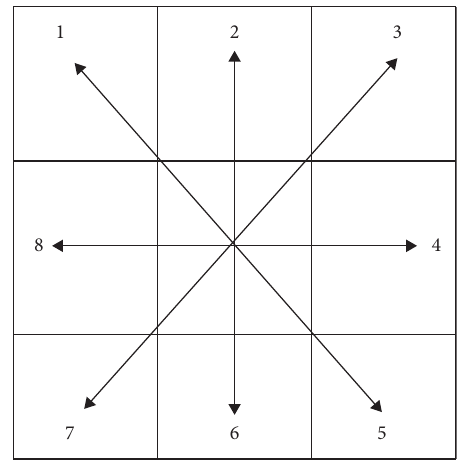
Figure 2: Direction of robot